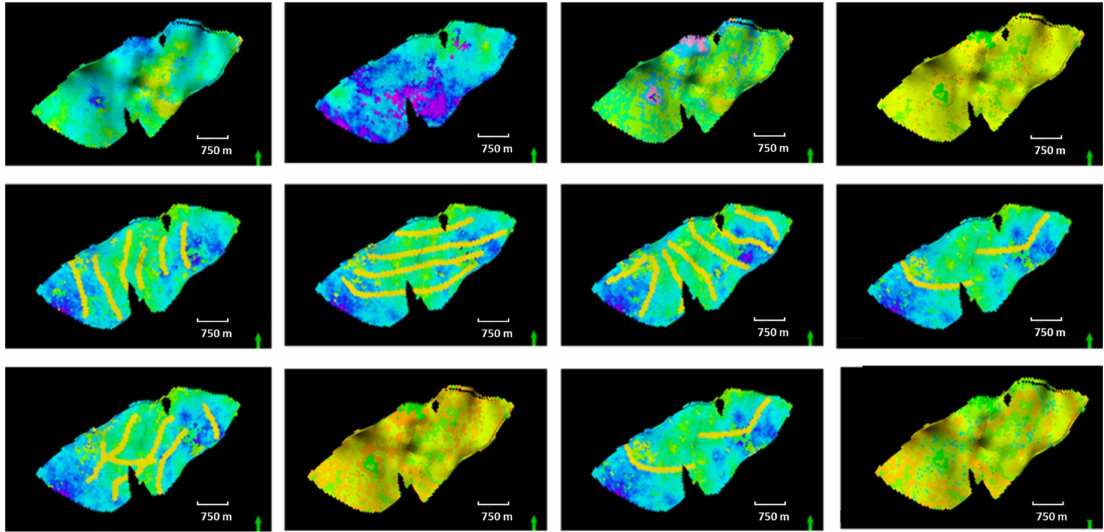
Figure 3. Geomodel ensemble used to generate training dataset.